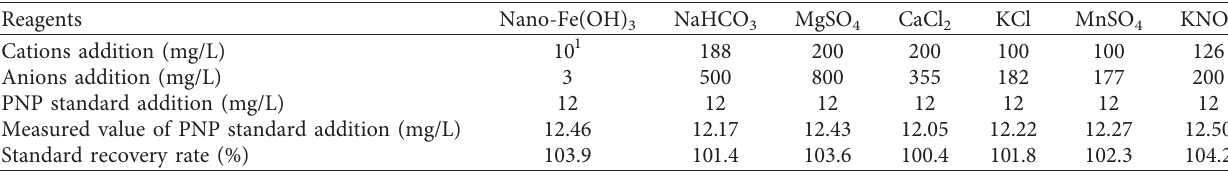
Figure 5: (a) Reduction of Fe(III) by AA. (b) Research on Fe(OH) 3 interference elimination. Table 3: The nano-Fe(OH) 3 and coexisting ions interference